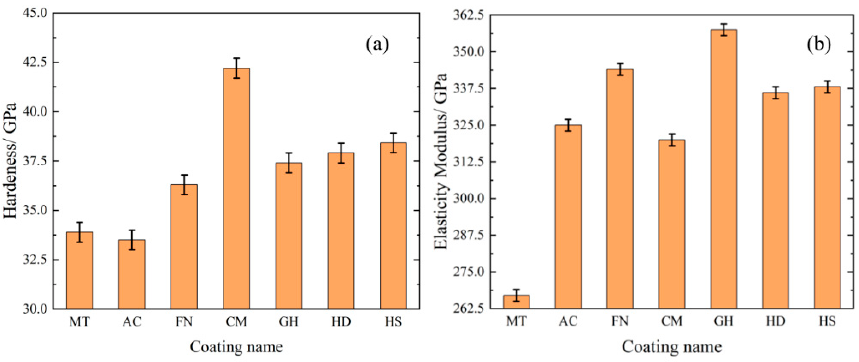
Figure 9. Hardness and elastic modulus of different coatings.